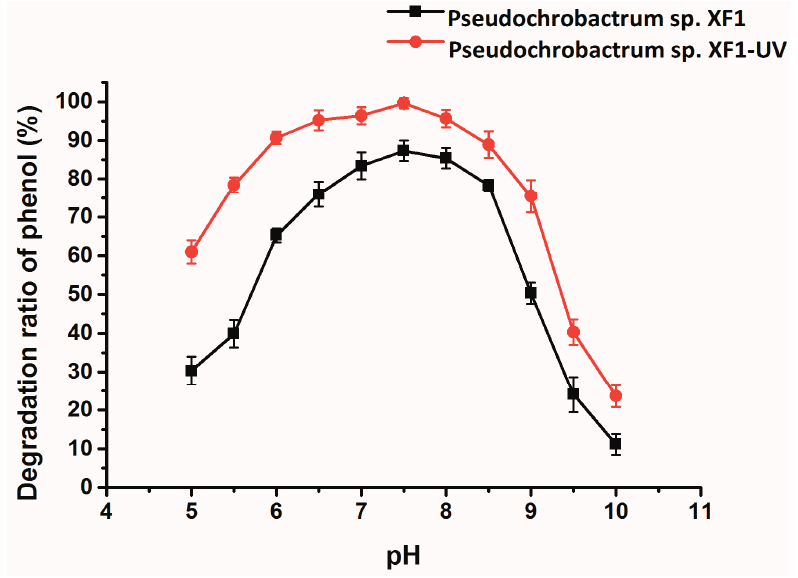
Figure 3. The effect of pH on phenol degradation by Pseudochrobactrum sp. XF1 and Pseudochrobactrum sp. XF1-UV. Error bars indicate standard